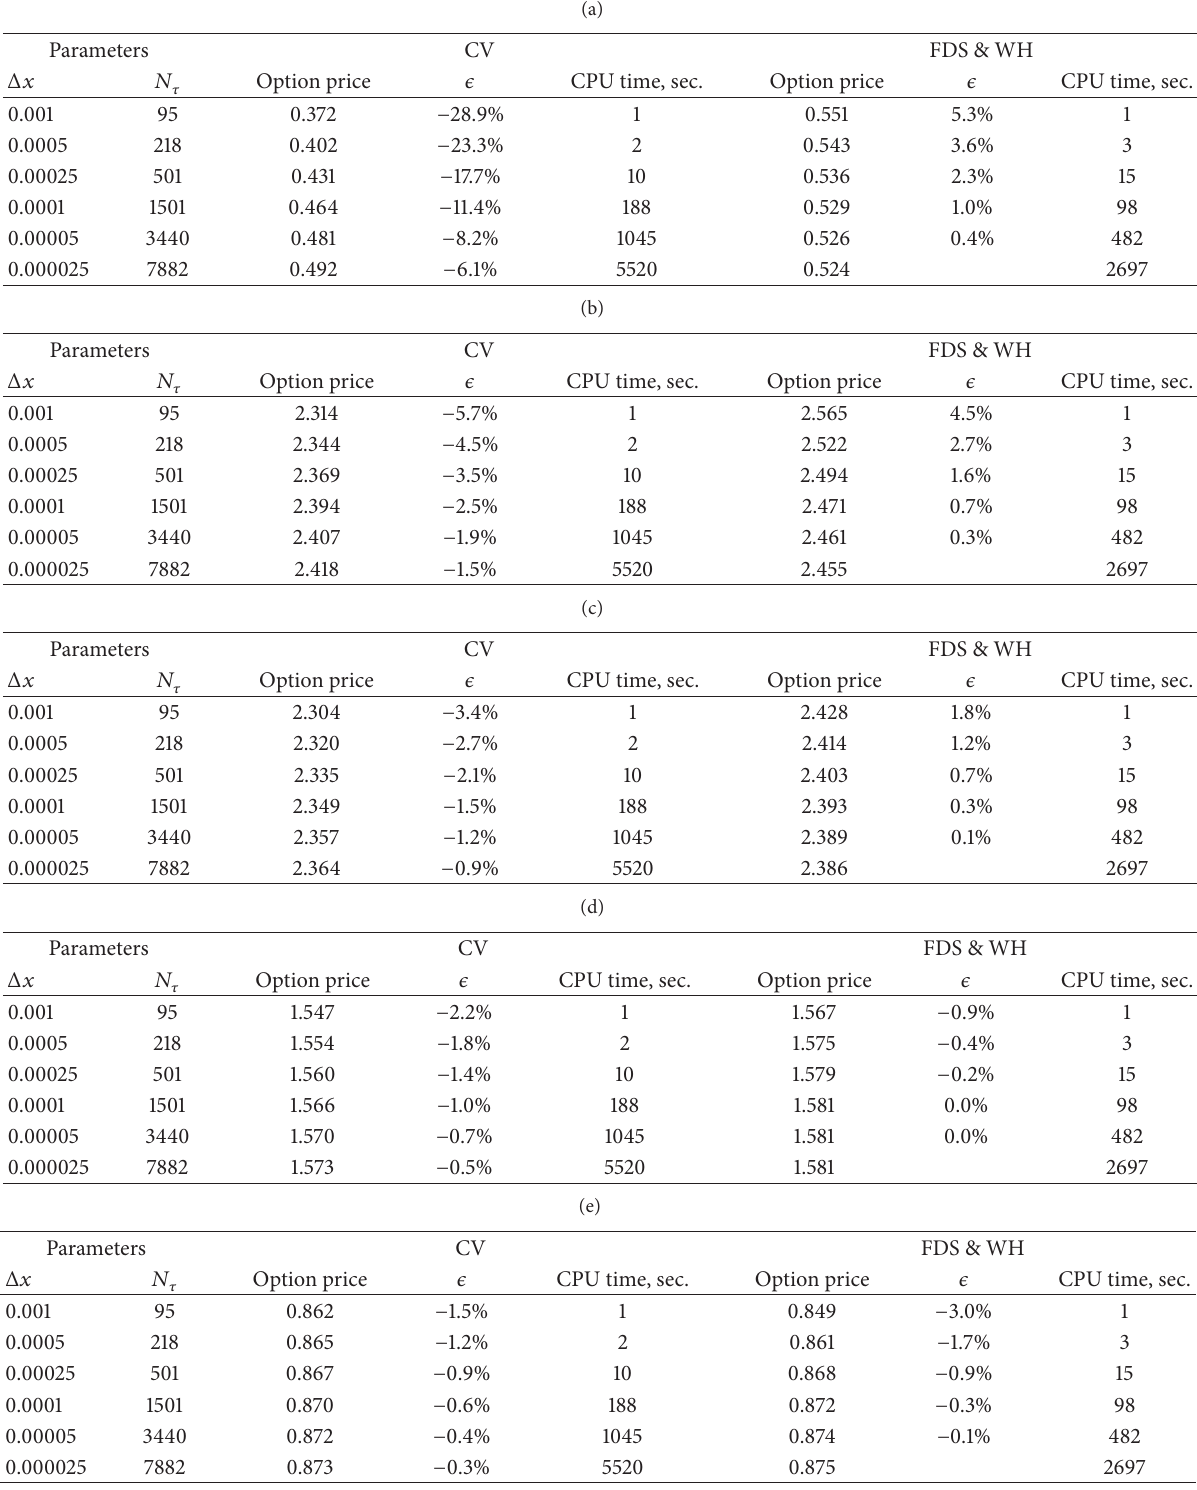
Table 2: Convergence of the down-and-out put prices in KoBoL model, ] > 1 : FDS & WH versus